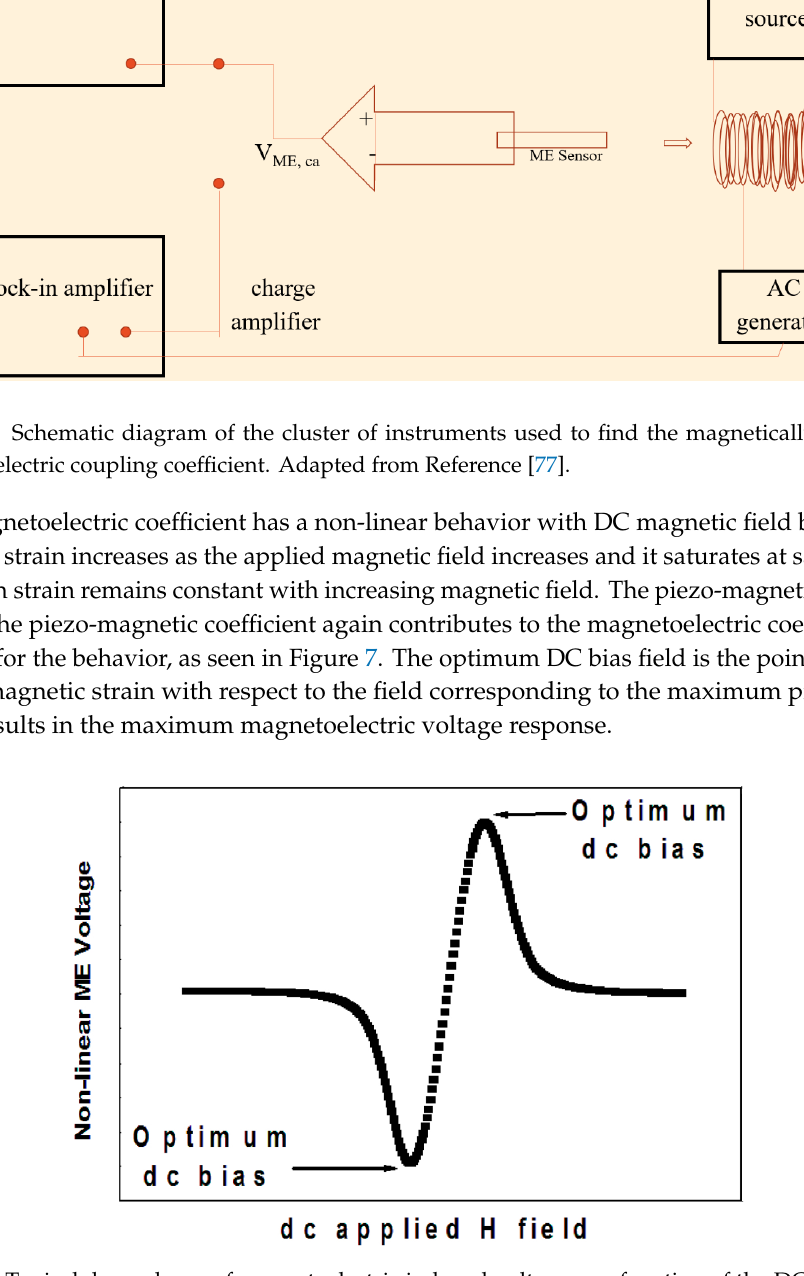
Figure 7. Typical dependence of magnetoelectric induced voltage as a function of the DC magnetic bias field at constant AC magnetic field amplitude. As seen in Reference [78].